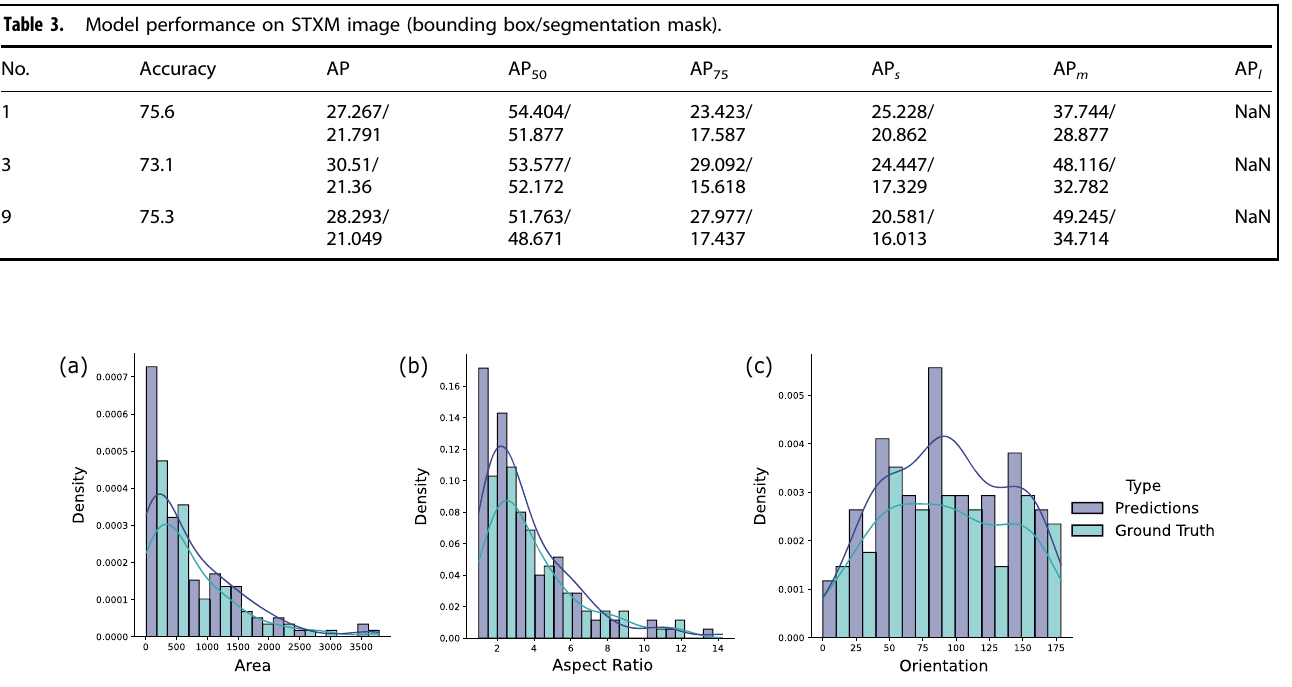
Fig. 7 Particle statistics from the STXM image. Histograms and KDE curves are illustrated as a function of area, aspect ratio, and orientation in a – c , respectively. The statistical results show good qualitative and quantitative agreement. The main reason for the shift of KDE curves are due to the FP pixels, leading to higher density estimates in the respective number range.